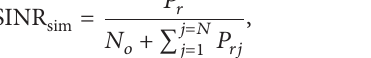
transmitter, receiver, and a channel (medium) between